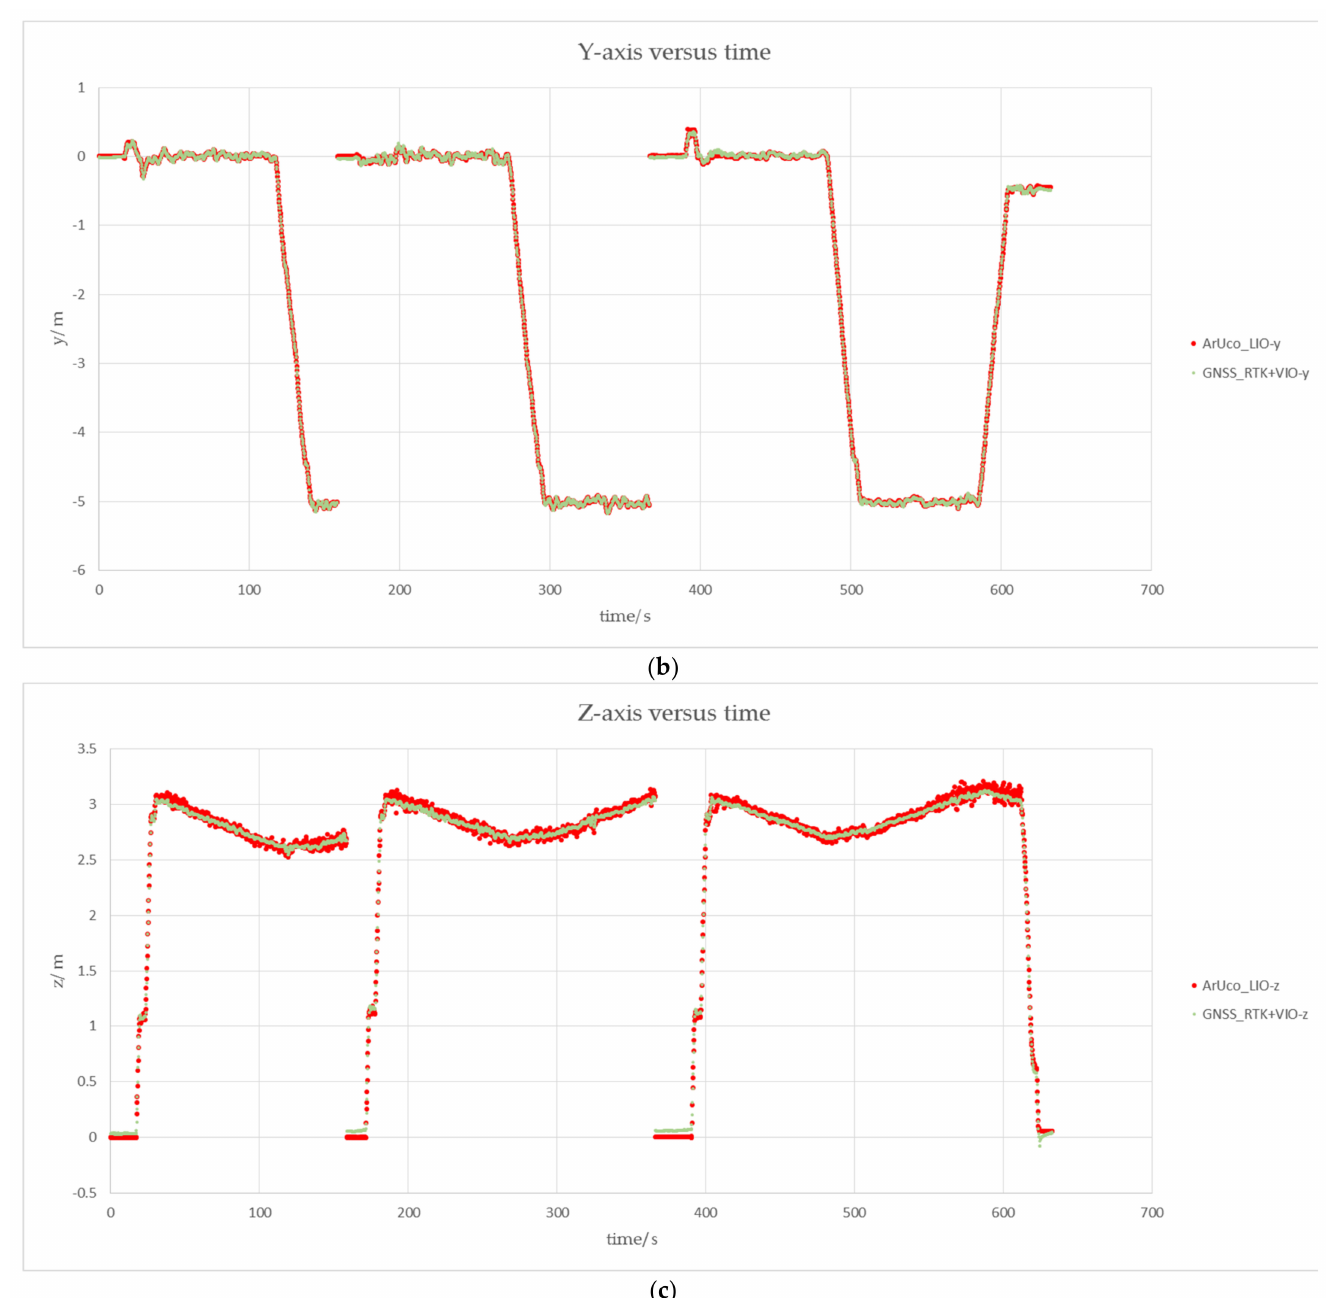
Figure 15. The changes in X, y, and Z directions of the path with time. Where ( a ) is the x-axis variation curve with time. ( b ) is the y-axis variation curve with time. ( c ) is the z-axis variation curve with time. The scatter diagram of the navigation system positioning error is shown in Figure 16. The red scatters “error” and “error-XY” are the distance error between the ArUco_LIO and the true value of the three-dimensional position and the horizontal projection position, with DRMS of 0.04802 m and 0.03407 m, respectively. The blue scatters, “error-x,” “error-y,” and “error-z” are, respectively, the absolute errors in the X, y, and Z directions of ArUco_LIO in the test, with an RMS of 0.02876 m, 0.01826 m, and 0.03385 m. Therefore, under this working condition, the horizontal accuracy of ArUco_LIO is 0.03407 m, and the vertical accuracy is 0.03385